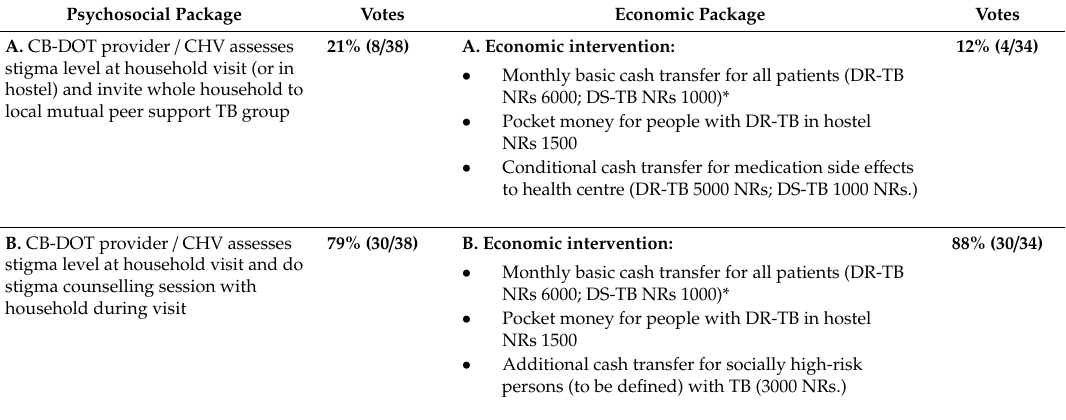
Table 3. Design of and votes for psychosocial and economic elements of potential integrated socioeconomic support package for people with